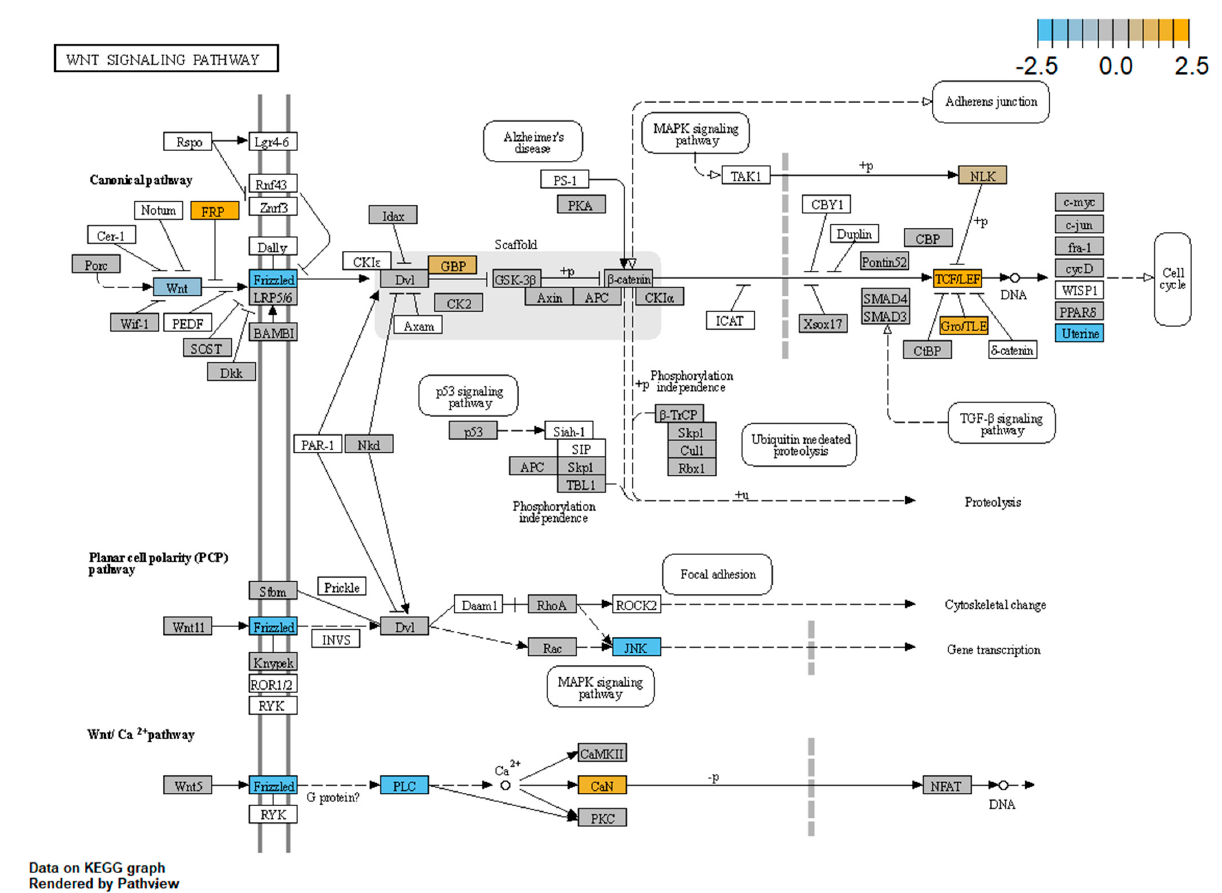
Figure 7. Schematic representation of DEGs in the CdLS cell lines belonging to the three main WNT pathways (figure rendered by Pathview, nSolver Advanced Analysis Software 4.0). Pathway nodes shown in white have no genes in the Vantage 3DTM RNA WNT Pathways Panel. Pathway nodes in grey have corresponding genes in the panel, however no significant differential expression is observed. Nodes in blue and orange denote downregulation or upregulation in CdLSs compared to CTRLs. Node Frizzled, DEGs: FZD3 , FZD5 , FZD8 and FZD10 ; node Wnt, DEG: WNT10B ; node FRP, DEG: SFRP1 ; node GBP, DEG: FRAT1 ; node TCF/LEF, DEGs: TCF4 , LEF1 and TCF7L1 ; node Gro/TLE, DEG: TLE1 ; node Uterine, DEG: MMP7 ; node JNK, DEG: MAPK10 ; node PLC, DEG: PLCB1 ; node CaN, DEGs: PPP3CA and PPP3CC . Finally, we performed three different expression analyses splitting CdLSs samples based on NIPBL and SMC1A involvement, comparing NIPBL -mutated CdLSs vs. CTRLs